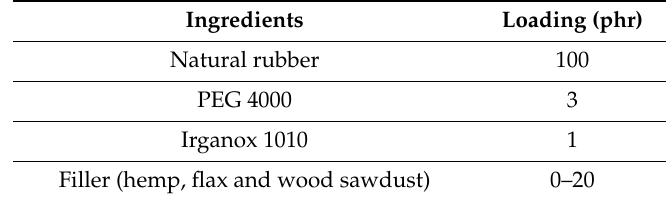
Table 2. Blends composition, ingredients and loading expressed in Parts per Hundred Rubber (phr).